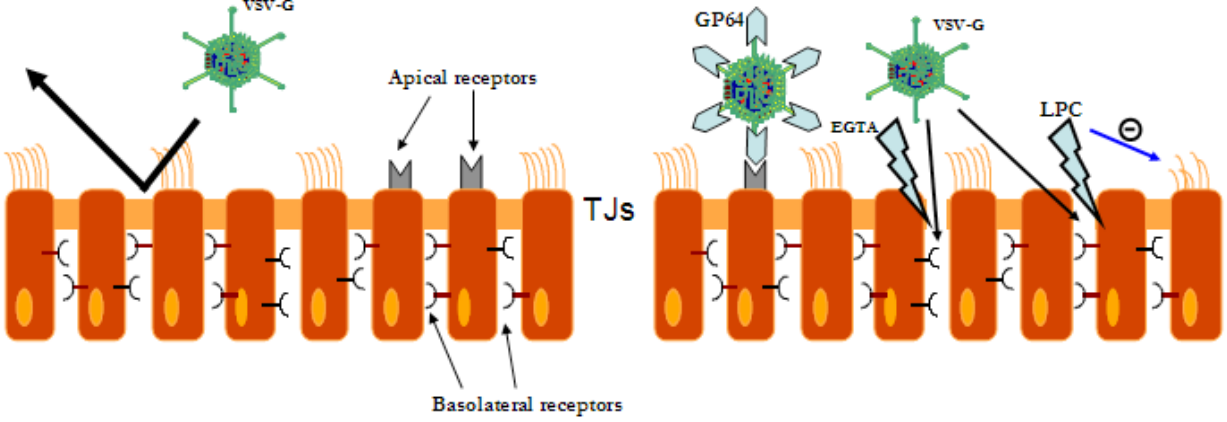
Figure 1 . VSV-G LV vectors have been shown to be inefficient in in vivo gene transfer into a fully differentiated epithelium unless treatment with agents that disrupt the TJ integrity (EGTA; LPC) exposing basolateral receptors to the vector. LPC acts also increasing vector residence time by reducing cilial beat (blue arrow). To overcome the inability of VSV-G LV to efficiently infect the airway epithelium in the absence of injuring agents other heterologous envelope glycoproteins than VSV-G (e.g., GP64 from baculovirus A. Californica ) conferred to the LV vector the ability to transduce differentiated airway epithelium from the apical